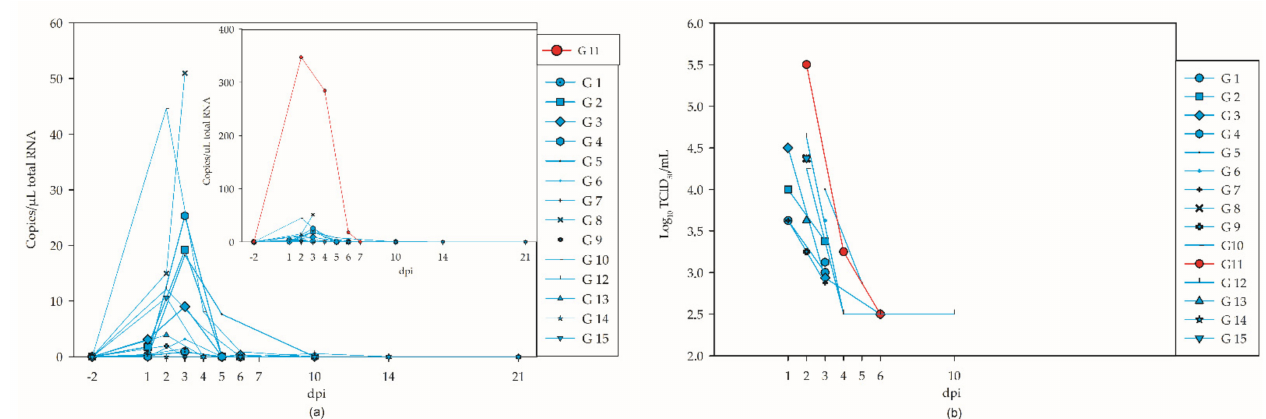
Figure 3. Viremia of the geese. The negative results of the controls (G 16–G 18) are not shown. ( a ) Results of RT-qPCR without G 11 (left) and for all WNV-inoculated geese (top right), using differ- ent y-scales. ( b ) Results of virus titration for RT-qPCR-positive